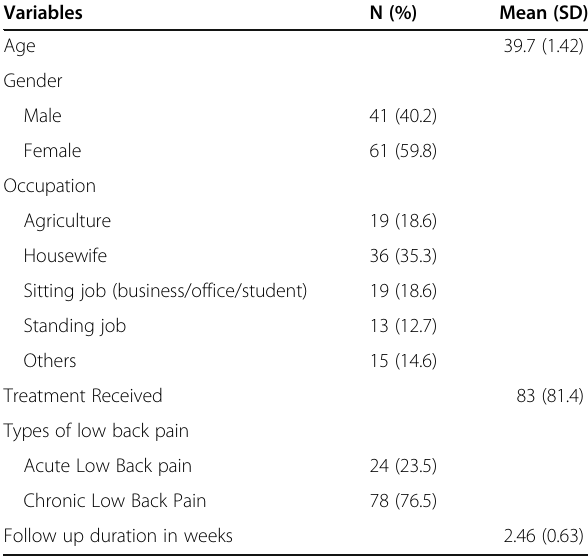
Table 1 Demographic characteristics of the sample ( n = 102) Variables